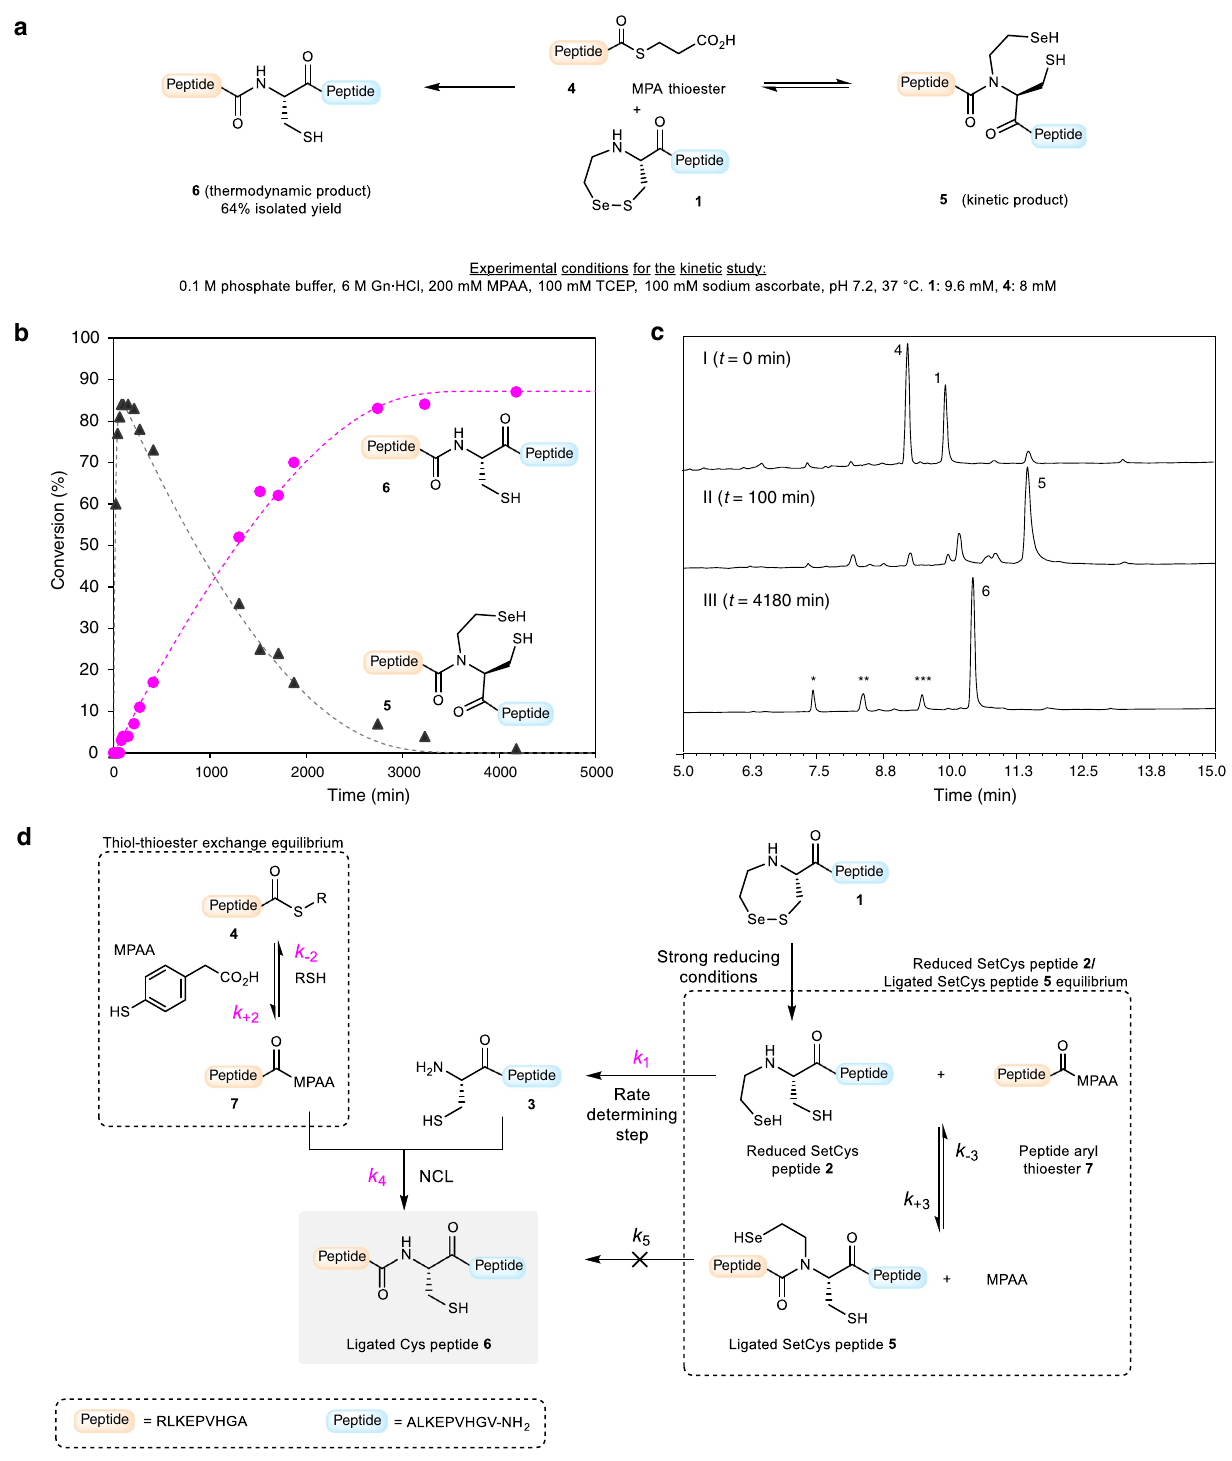
Fig. 4 Insights into the mechanism of SetCys-mediated ligation. a Ligation of SetCys peptide 1 with peptide thioester 4 in NCL standard conditions yields peptide 6 featuring a native peptide bond to cysteine. b RP-HPLC monitoring of the formation of peptides 5 (black triangles) and 6 (magenta dots) throughout the course of the reaction. Fitting curves for each compound are represented by dashed lines. Each aliquot corresponds to one data point on each trace and was measured once ( n = 1). c Representative RP-HPLC chromatograms of the reaction in a at t = 0, 100, and 4180 min (the labeled peaks *, **, *** correspond to TCEP derived-selenophosphine, hydrolysis side-product of peptide thioester 4 , and Cys peptide 3 , respectively). d Proposed mechanistic model for the ligation of N -(2-selenoethyl)cysteine peptides under strong reducing conditions. The rate constants were obtained by software- assisted numerical integration of rate equations (Kintek explorer TM ). Rate constants and associated standard errors were estimated based upon the covariance matrix resulting from nonlinear regression fi tting (Supplementary Table 5). Rate constants in magenta were determined separately from model